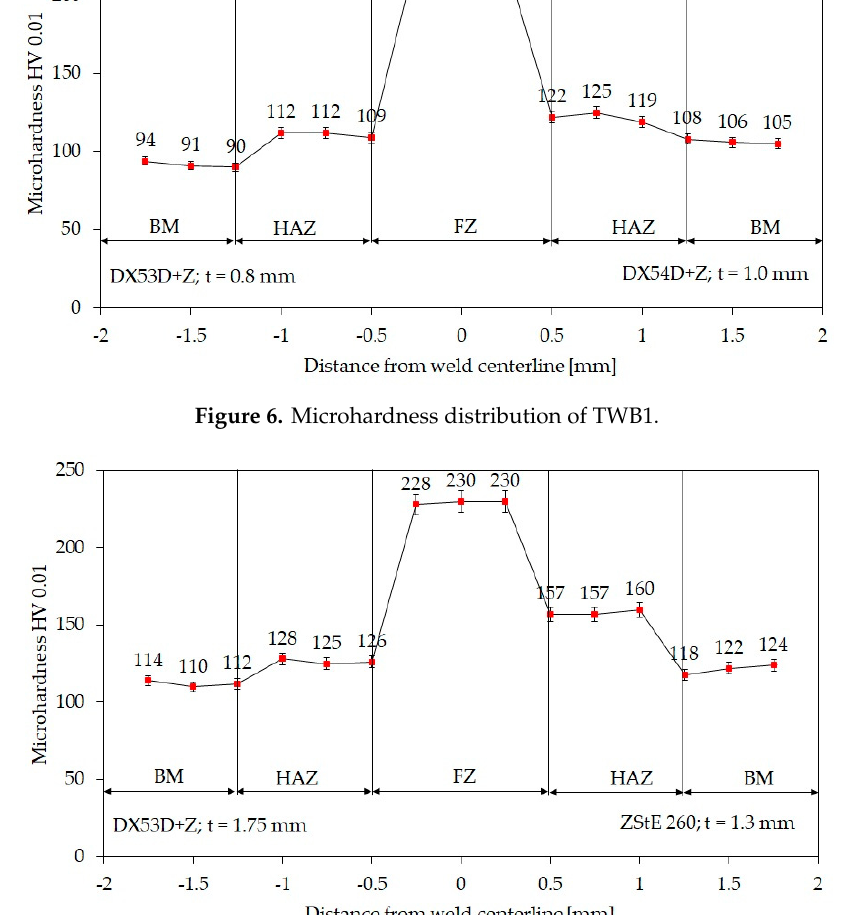
Figure 7. Microhardness distribution of TWB2.